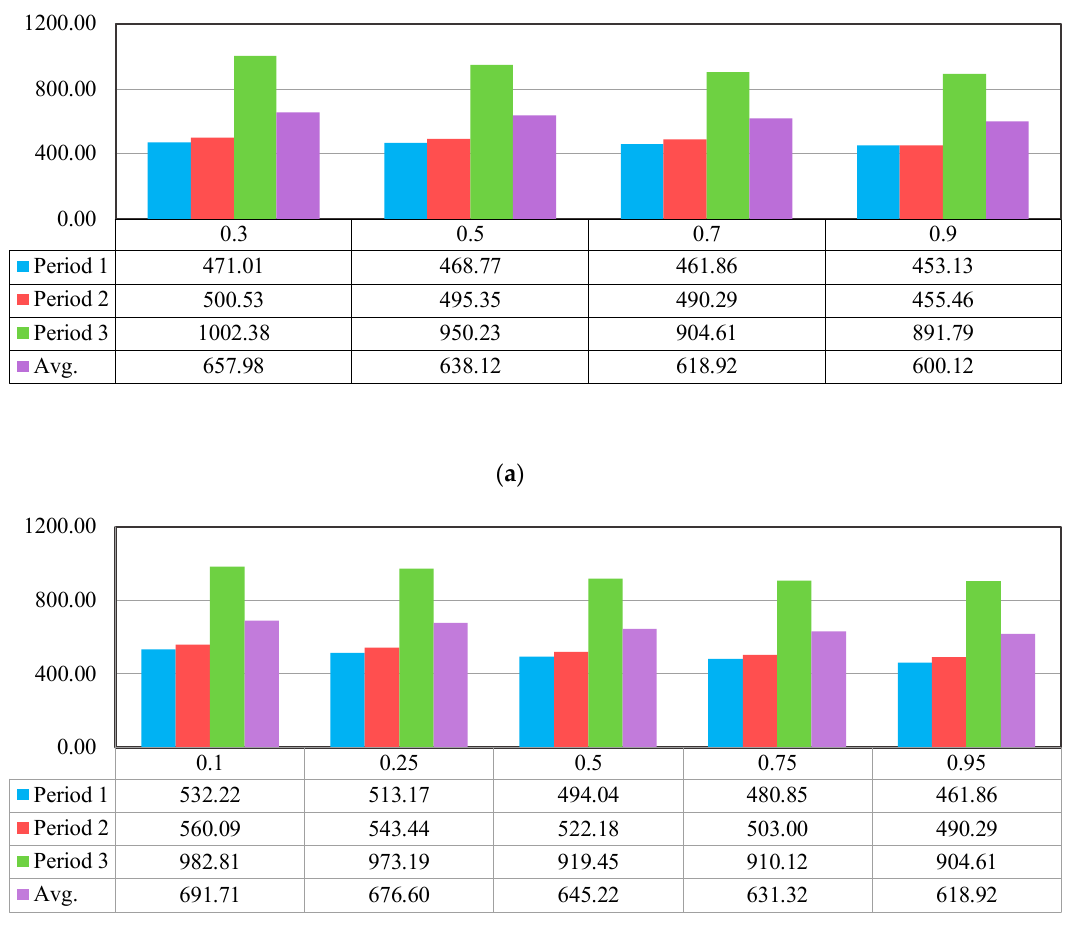
α ( a ); and α ( b ). 2 1